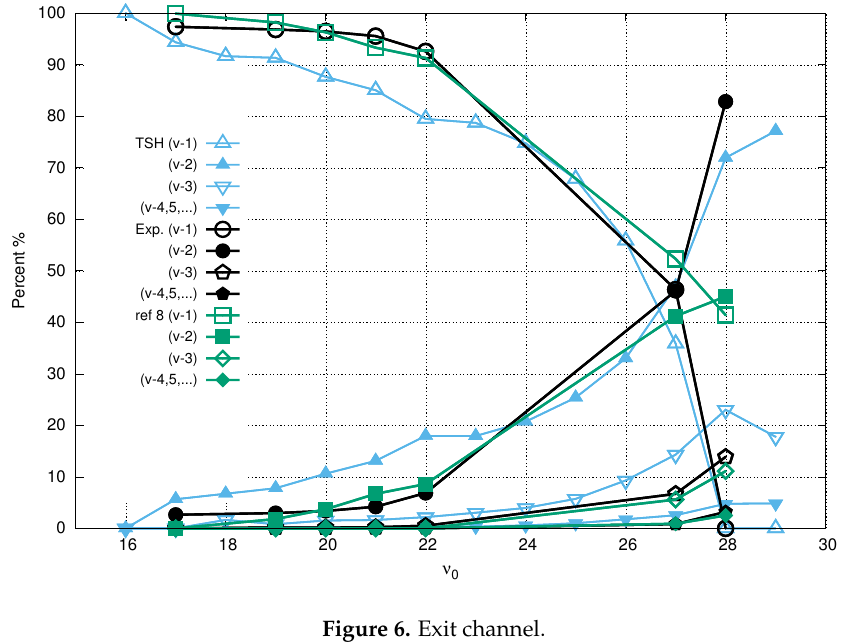
Figure 6. Exit channel.